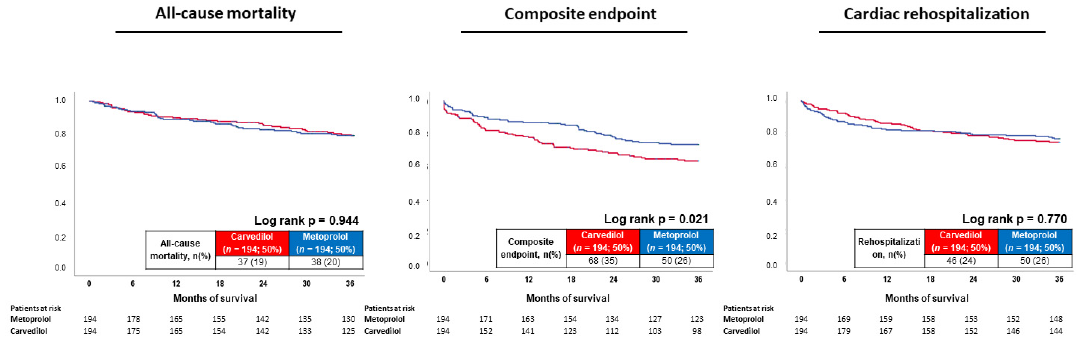
Figure 3. Prognostic impact of metoprolol versus carvedilol treatment on all-cause mortality ( left ), risk of the composite endpoint (i.e., recurrence of ventricular tachyarrhythmias, sudden cardiac death) ( middle ), and cardiac rehospitalization ( right ) after propensity score matching.